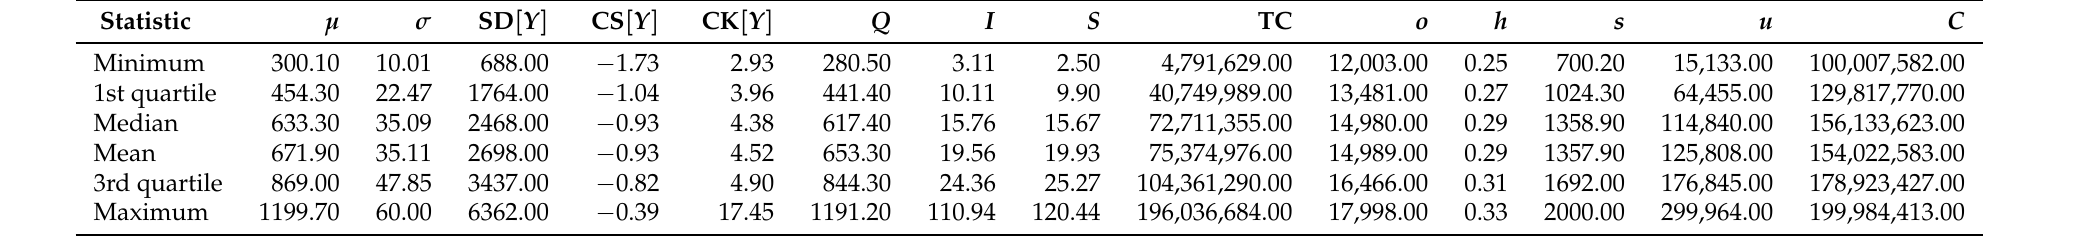
Table 5. Descriptive statistics for the indicators of the 10,000 scenarios of the simulation study.